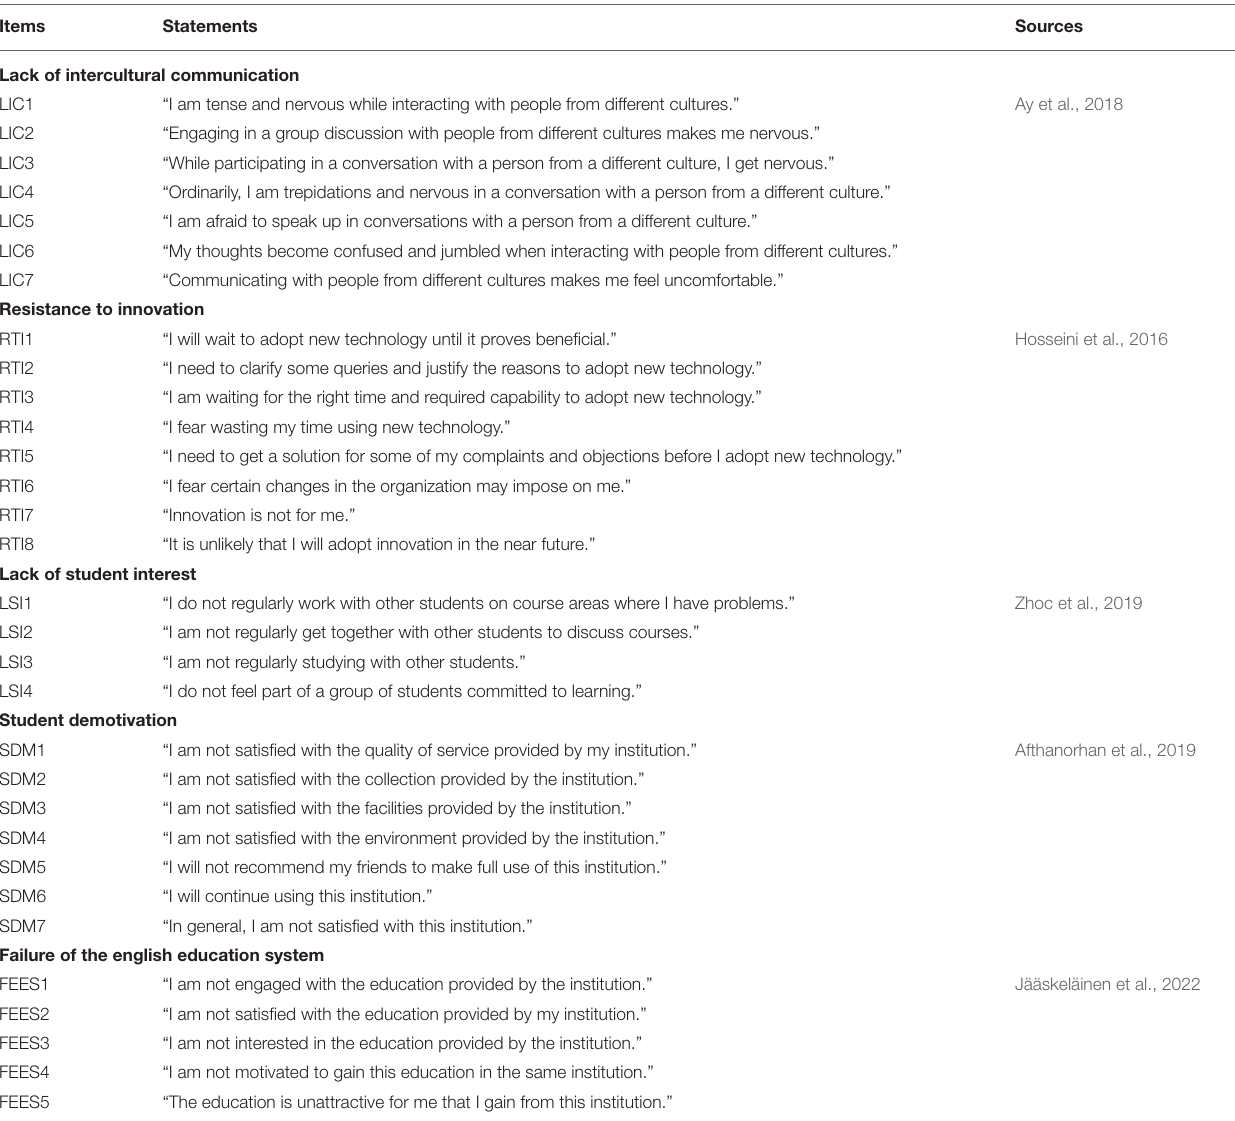
TABLE 1 | Questionnaire of the